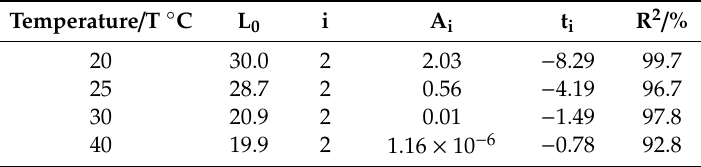
Table 5. Related coe ffi cients for limit load and